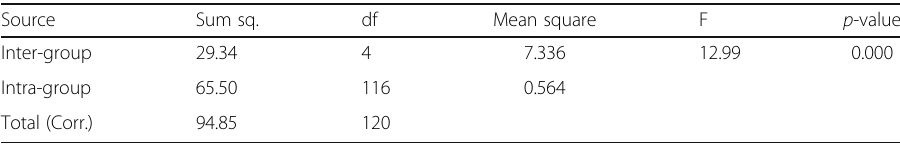
Table 4 ANOVA of progress in experimental and control groups Source Sum sq. df Mean